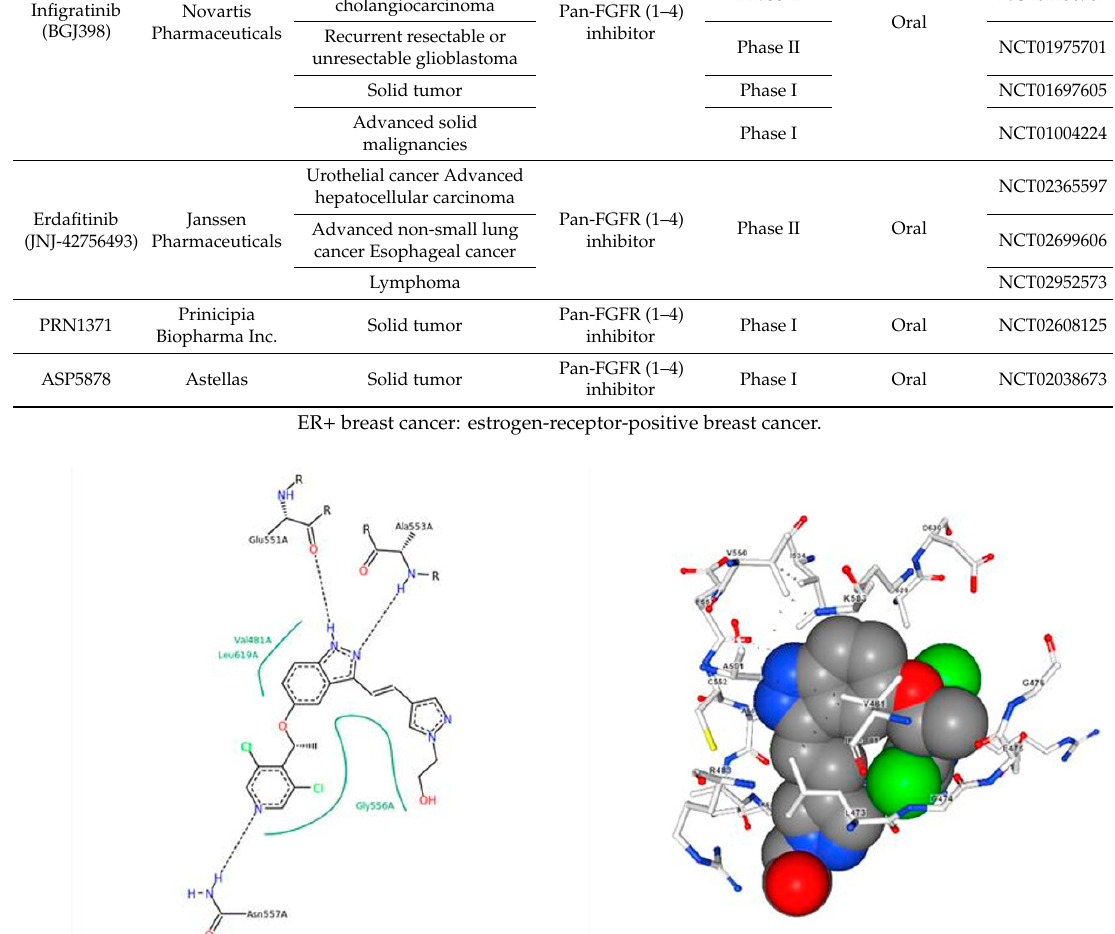
Figure 9. ( a ) Structure of JNJ-42756493 ( b ) Interaction of JNJ-42756493 with FGFR1 (PDB code 5EW8). PRN1371 (NCT02608125) and ASP5878 (NCT02038673) are drugs designed to target pan- FGFRs and are in phase I of development and clinical trials. PRN1371 was developed by Principia Biopharma Inc. for solid tumors. It is an irreversible inhibitor that specifically targets FGFRs . The inhibitory action of this drug has been reported in many tumor types like HCC, gastric, and lung